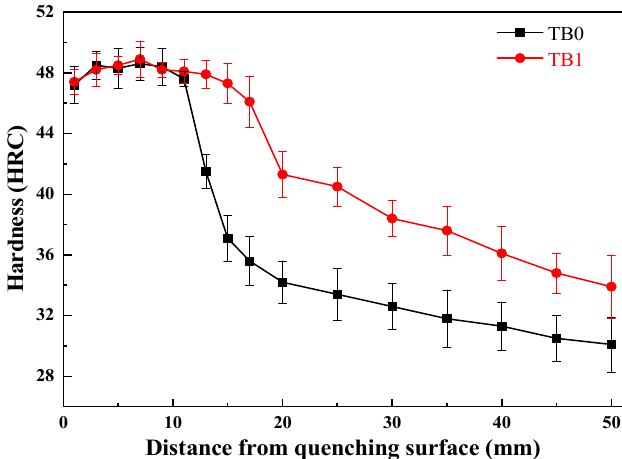
Figure 4. Quenching hardness curves of TB0 and TB1 steels.